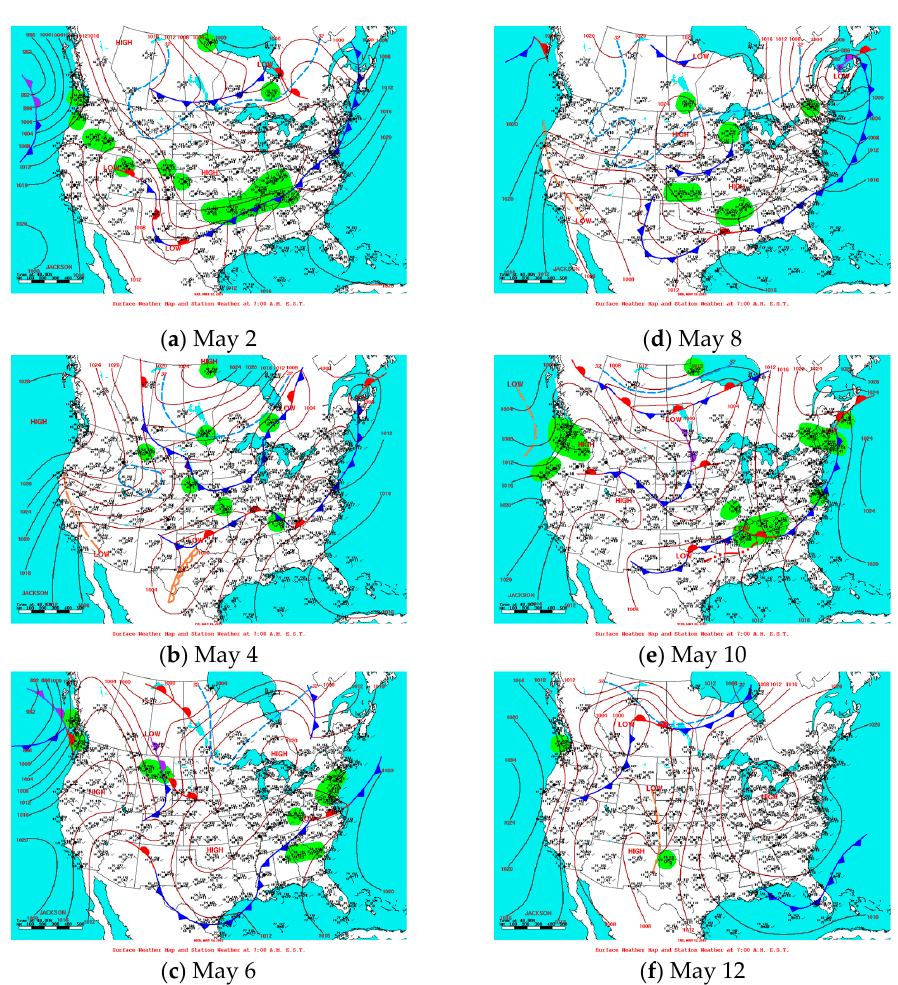
Figure 4. Surface weather maps for ( a ) 2 May, ( b ) 4 May, ( c ) 6 May, ( d ) 8 May, ( e ) 10 May, and ( f ) 12 May 2009 at 1200 UTC (0700 local time in SE US). Sea level pressure (contours), frontal systems and surface station weather observations are also shown. From the Weather Prediction Center at the National Center for Environmental Prediction (available at https://www.wpc.ncep.noaa.gov/